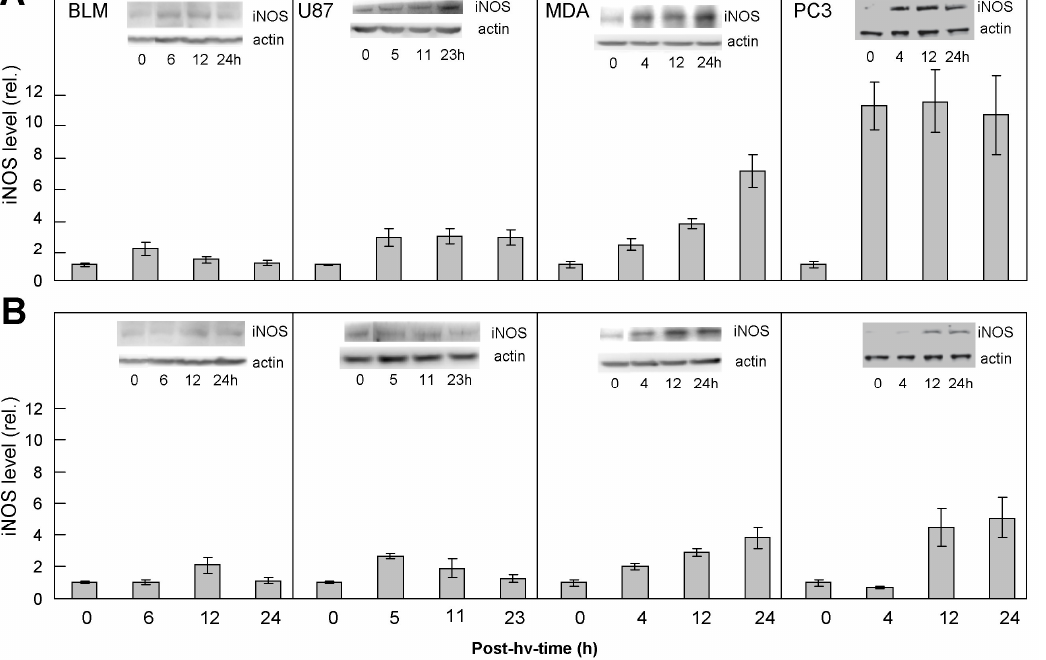
Figure 1. Western blots showing upregulation of iNOS in photodynamically-targeted BLM, U87, MDA-MB-231, and PC-3 cells ( A ) and corresponding bystander cells ( B ). Target cells of each type were incubated for 40 min in the dark with 1 mM 5-aminolevulinic acid (ALA) in medium without serum or phenol red. Cells were then switched to ALA-free medium and exposed to the following light fluences: 0.2 J/cm 2 (MDA-MB-231 cells); 1.0 J/cm 2 (BLM, U87, PC3 cells). Bystander cells within two silicone rings were irradiated concurrently. Two hours after irradiation, rings were removed, and the medium switched to 10%-serum-containing RPMI. After the indicated periods of post-irradiation dark incubation, cells from each compartment were recovered for immunoblot analysis of iNOS and β -actin. Cells from two bystander rings were combined for Western analysis. Total cellular protein: 30 µg per lane. Plotted values for each cell line represent iNOS band intensity relative to β -actin and normalized to time-0; means ±SEM ( n = 2–3). (No difference was observed between time-0 and dark (ALA-only) controls of targeted cells).